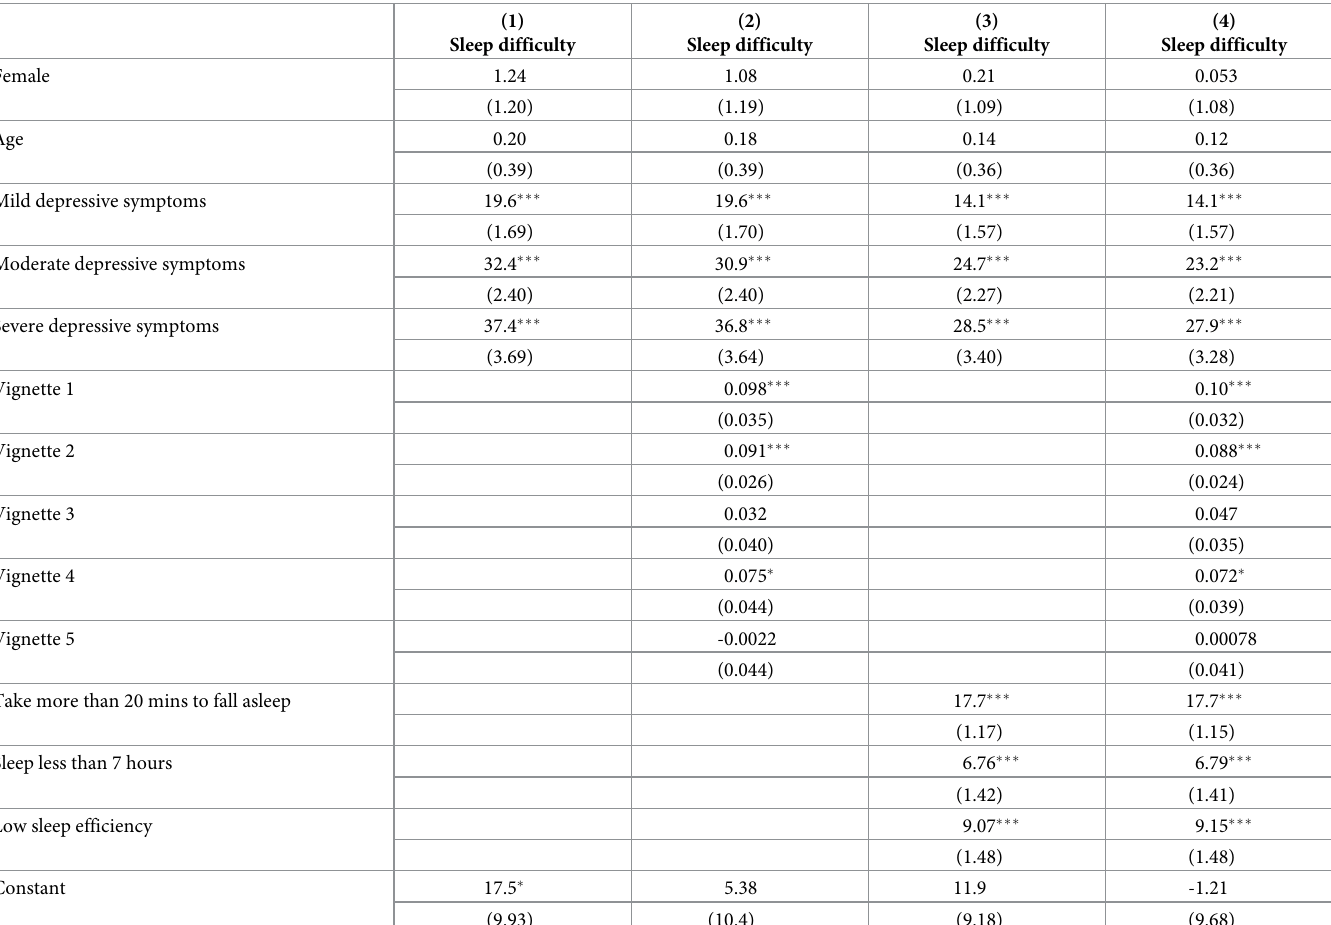
Table 4. Linear regressions of sleep difficulties on our set of control variables, including the vignette evaluations in columns 2 and